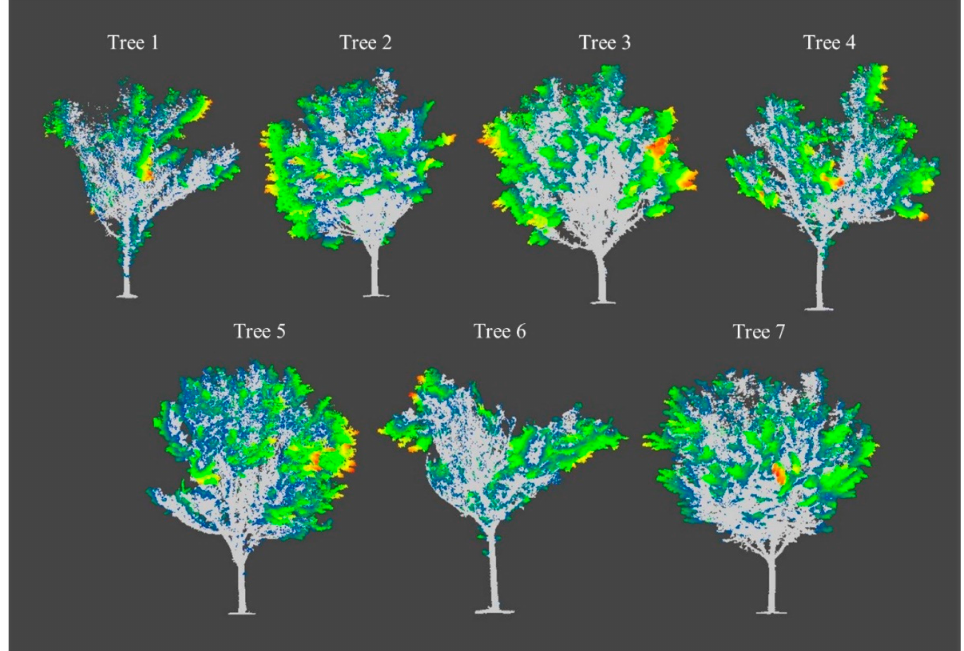
Figure 1. Trees obtained after registering the point clouds under the two phenological conditions. Color points: leaf. Gray points: wood.